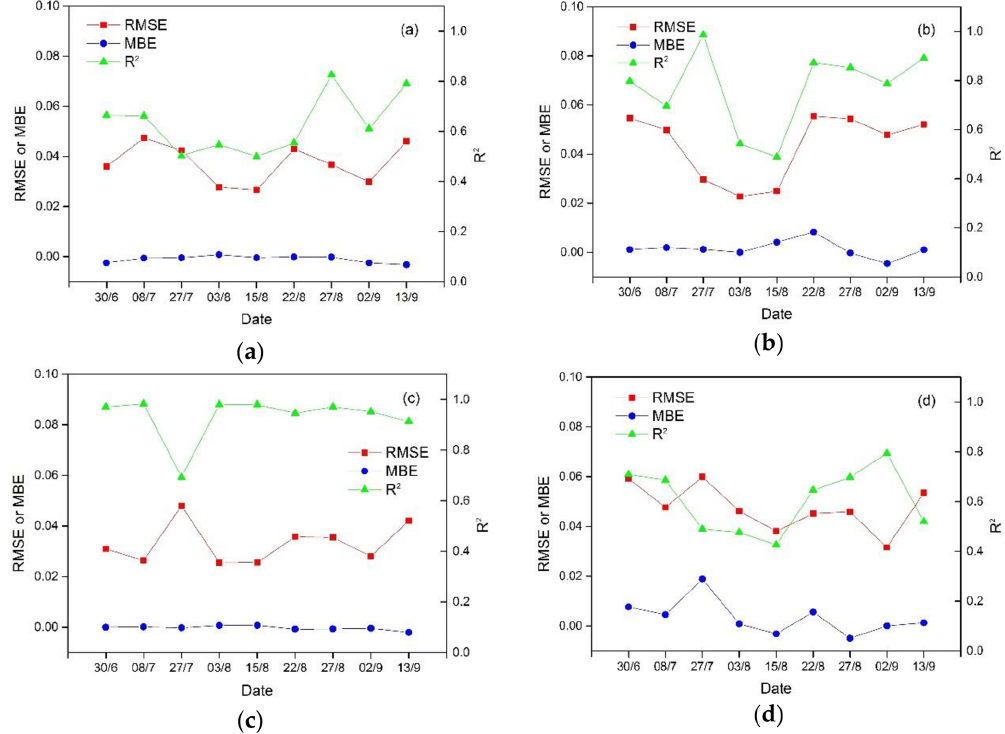
Figure 12. The RMSE, MBE and R 2 values of pure pixels based on the nearest pure pixel(s) for four land cover types: (a) maize, (b) grass- land, (c) bare soils and (d)